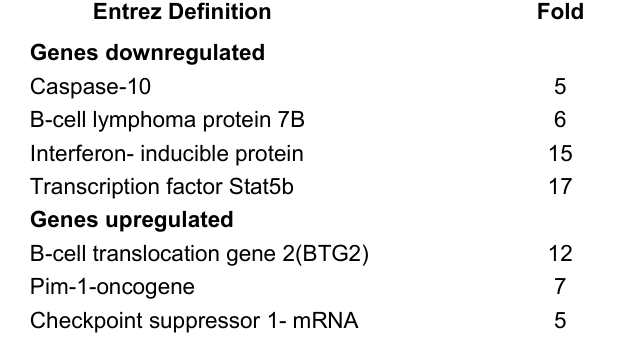
Fold Change and Entrez Definition of the Top 7